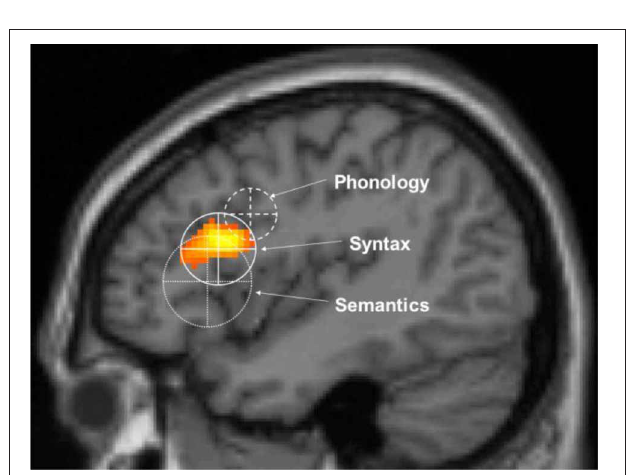
FIGURE 2 | The MUC model of language. The figure displays a lateral view of the left hemisphere. The numbers indicate Brodmann areas. These are areas with differences in the cytoarchitectonics (i.e., composition of cell types). The memory areas are in the temporal cortex (in yellow) including the angular gyrus in parietal cortex. Unification requires the contribution of Broca’s area (Brodmann areas 44 and 45) and adjacent cortex (Brodmann areas 47 and 6) in the frontal lobe. Control operations recruit another part of the frontal lobe (in pink), and the Anterior Cingulate Cortex (ACC; not shown in the figure), as well as areas involved in attention.